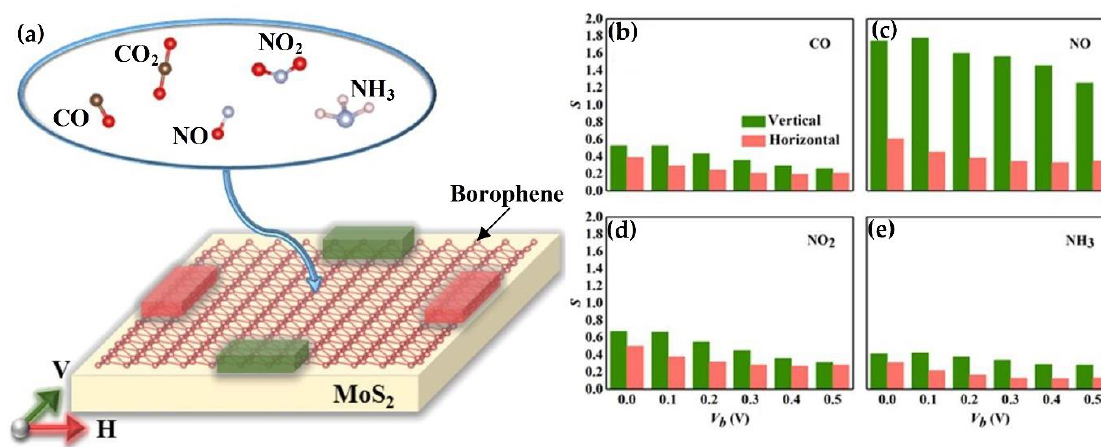
Figure 5. ( a ) Direction-sensitive borophene / MoS 2 heterostructure for multiple climate gas detection. Sensitivity and directional bias voltage of ( b ) CO, ( c ) NO, ( d ) NO 2 , and ( e ) NH 3 in the horizontal and vertical direction (Reproduced with permission from [168]. Copyright 2020 Elsevier B.V.).